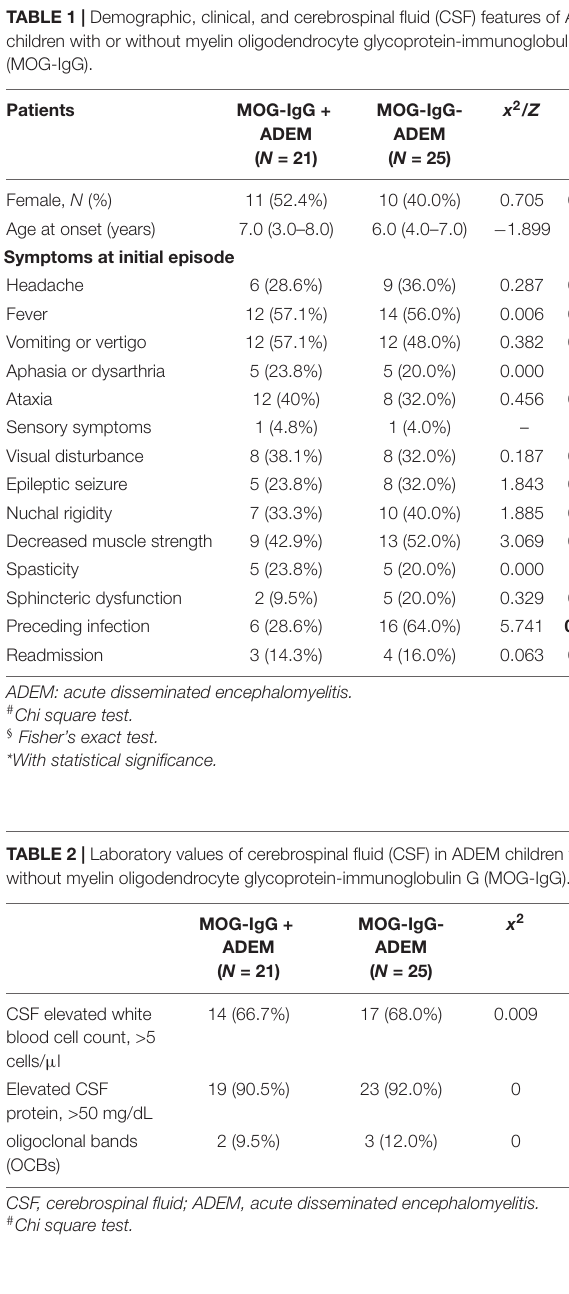
CSF elevated white blood cell count, >5